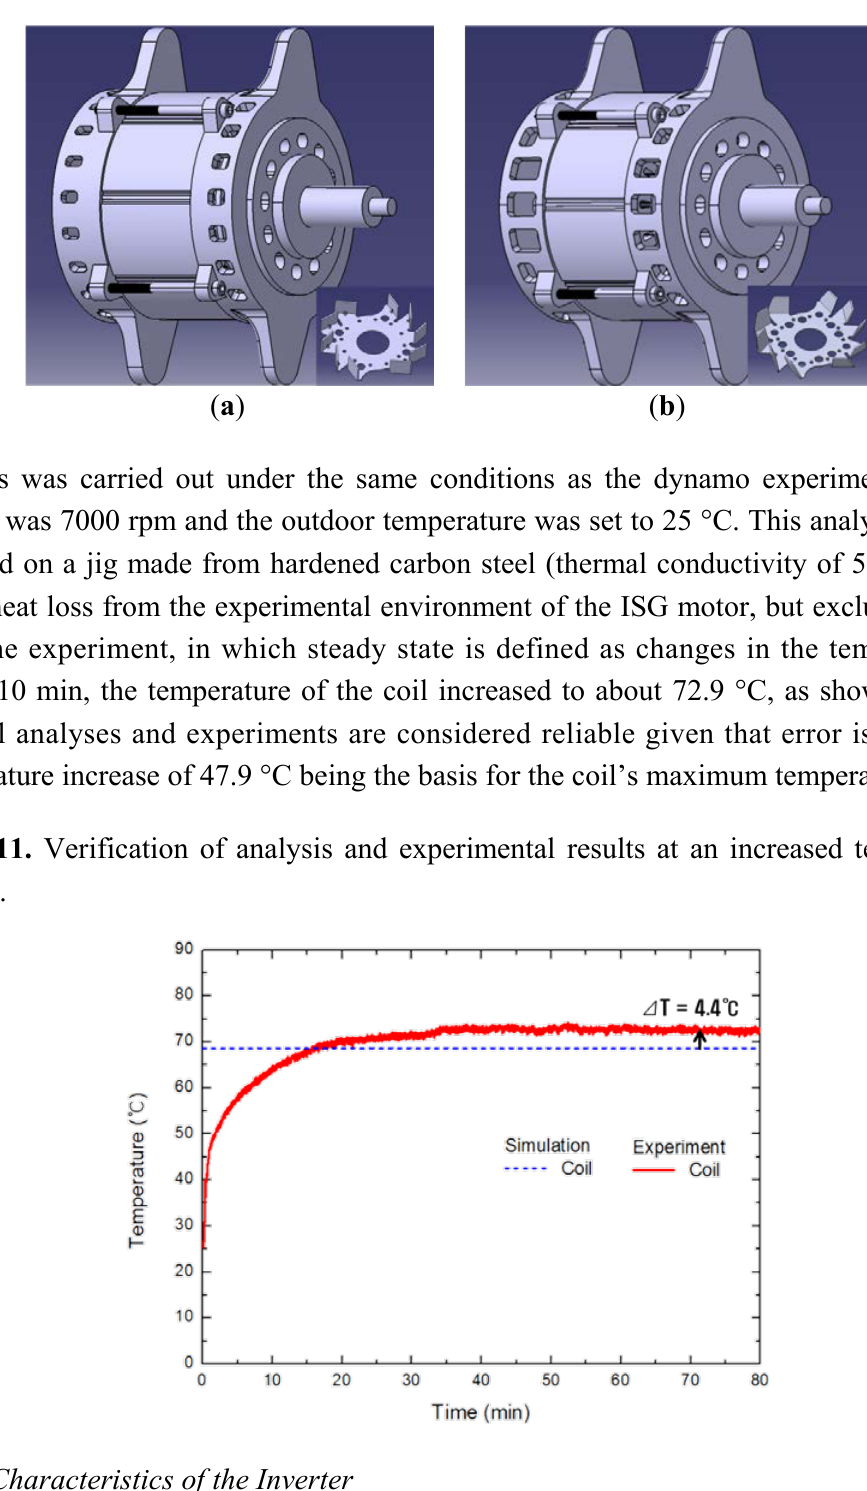
Figure 10. Shape of the original and modified ISG motor designs [18]: ( a ) original model; and ( b ) modified model.